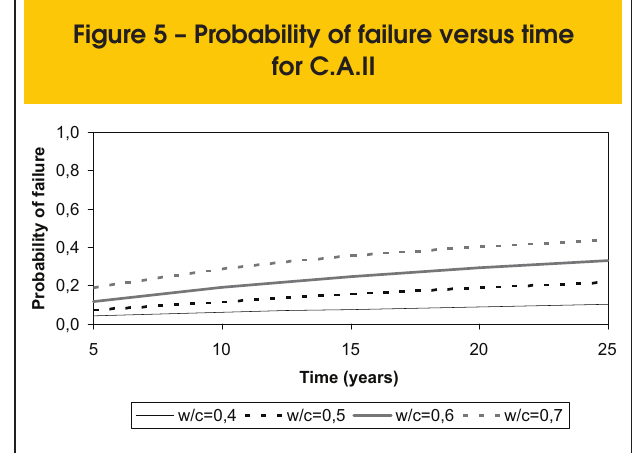
Figure 5 – Probability of failure versus time for C.A.II